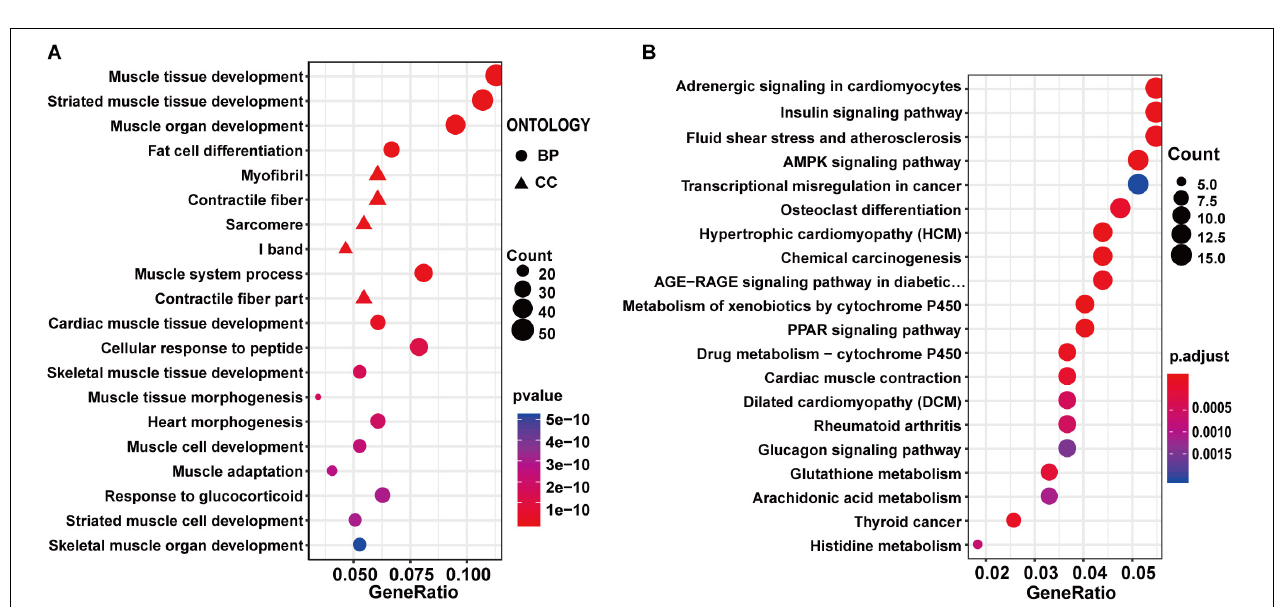
FIGURE 3 | GO and KEGG enrichment analysis of DEGs in exercise Wistar vs. Wistar comparison. The top 20 significantly enriched GO terms (A) and KEGG pathways (B)